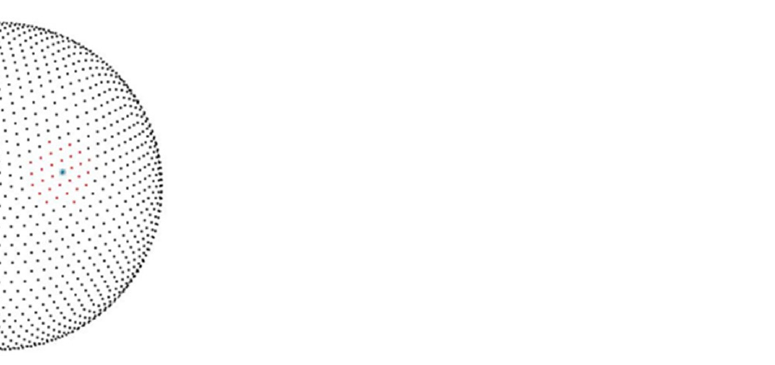
Figure 6. A local stencil of size 31 on the icosahedron spherical triangle mesh with refinement level 4. The center vertex is shown in blue asterisk and its nearest neighbor points are shown in red dot. For the above-mentioned four interpolation methods, the linear interpolation method and the Poly-LSQ method could be implemented without much effort; however, we need to take extra care in selecting the value of the shape parameter in the basis function if the RBF methods are utilized. If no specific explanations, for all the numerical experi- ments in Sections 4 and 5, the density of tracer or height fields are placed at the nodes of triangle